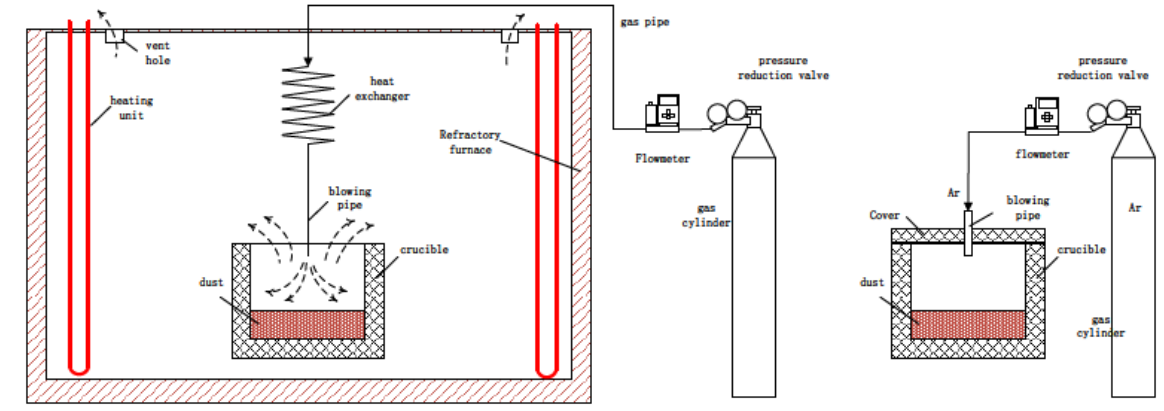
Figure 5: Experiment system for experiment (a) involving roasting in different atmosphere environments